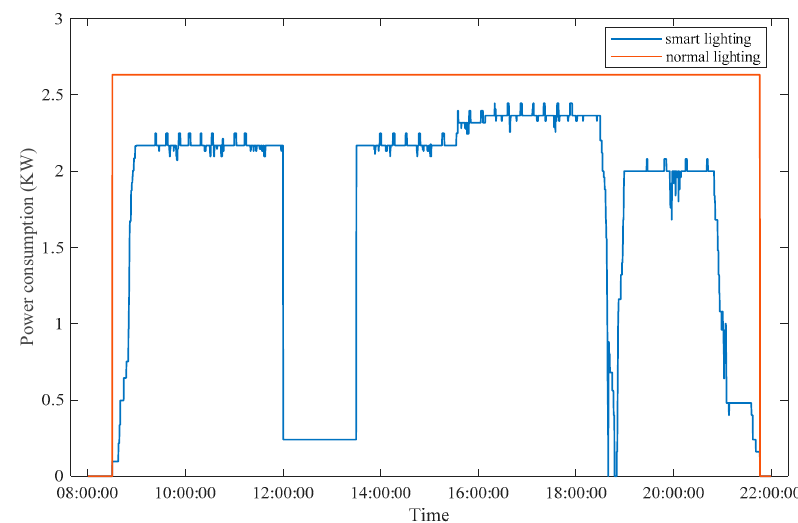
ffi ce hours and overtime